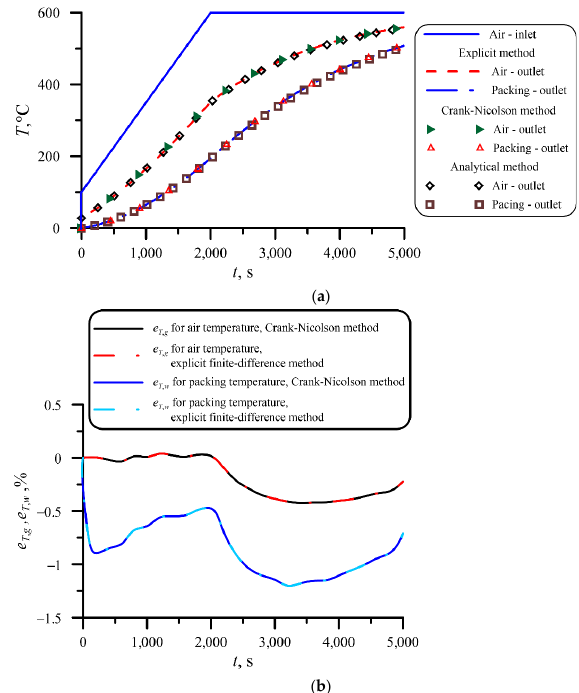
Figure 10. Air and packing temperature changes at the outlet of the accumulator; at the beginning, the air temperature increased in steps from 0 to 100 °C, then increased at a constant rate of 0.25 K/s, then remained stable after reaching 600 °C ( a ); and the relative difference between temperature de- termined using the exact analytical formula, the explicit finite-difference method, and the Crank – Nicolson method ( b ). analytical formula, the explicit finite-difference method, and the Crank–Nicolson method ( b